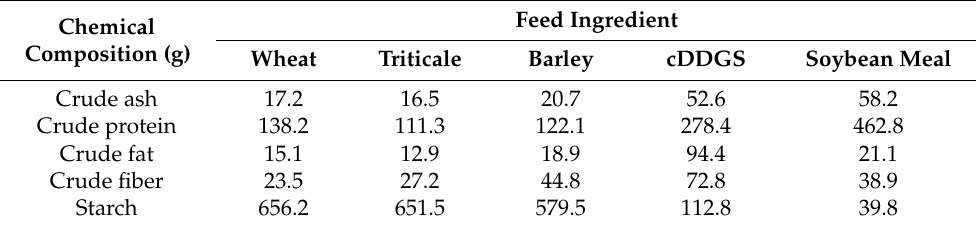
Table 1. Chemical composition of main feed